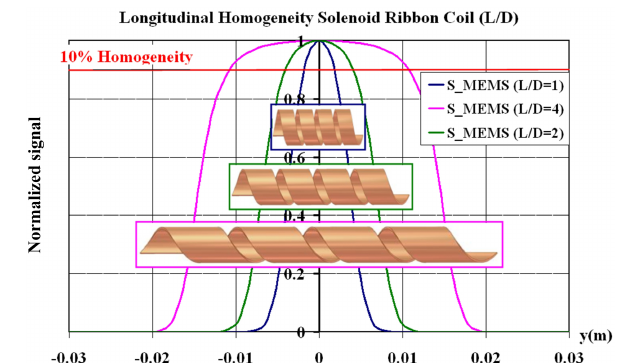
Figure 9. Comparisons of longitudinal homogeneity profiles for different solenoid coil aspect ratios.